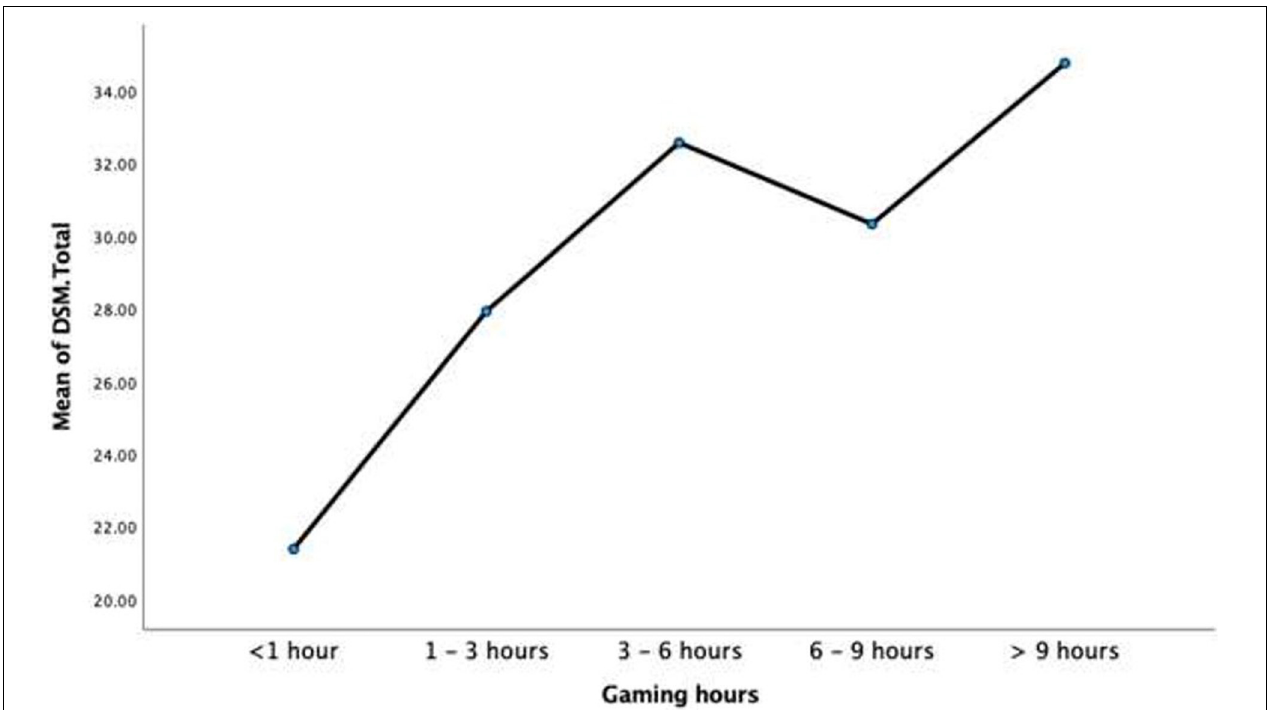
FIGURE 5 | Mean internet gaming disorder short scale (IGDSS) scores as a function of gaming hours.